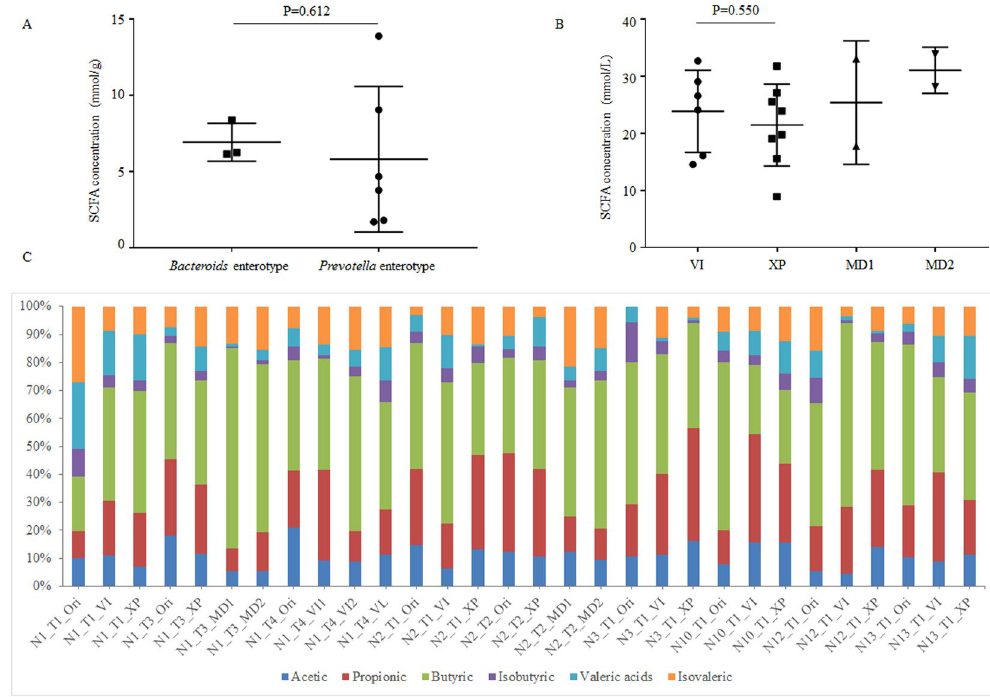
Figure 6. Total SCFA concentrations and relative percentages of SCFAs in fecal and fermentation samples. Acetic, propionic, isobutyric, butyric, isovaleric, and valeric acids were detected in the present study, and the total SCFA represents all SCFAs. The concentrations of SCFAs in the original fecal samples and batch chemostat were assessed using gas chromatography (GC). ( A ) Total concentration of SCFAs in original fecal samples (mmol/g). ( B ) Total concentration of SCFAs in fermentation samples (mmol/L). ( C ) The relative percentage of these SCFAs in each